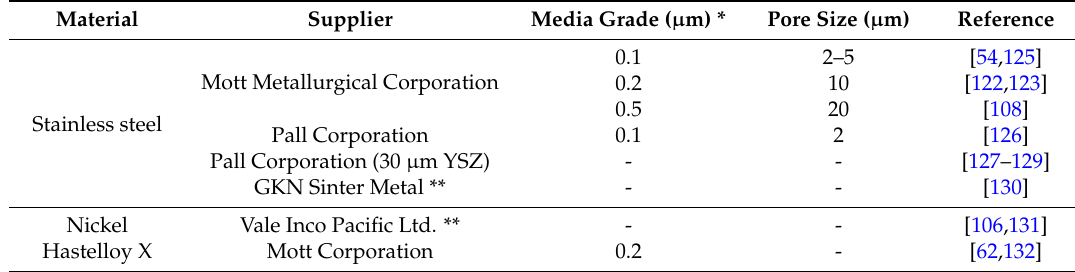
Table 7. Recently reported studies employing porous metal supports: materials and